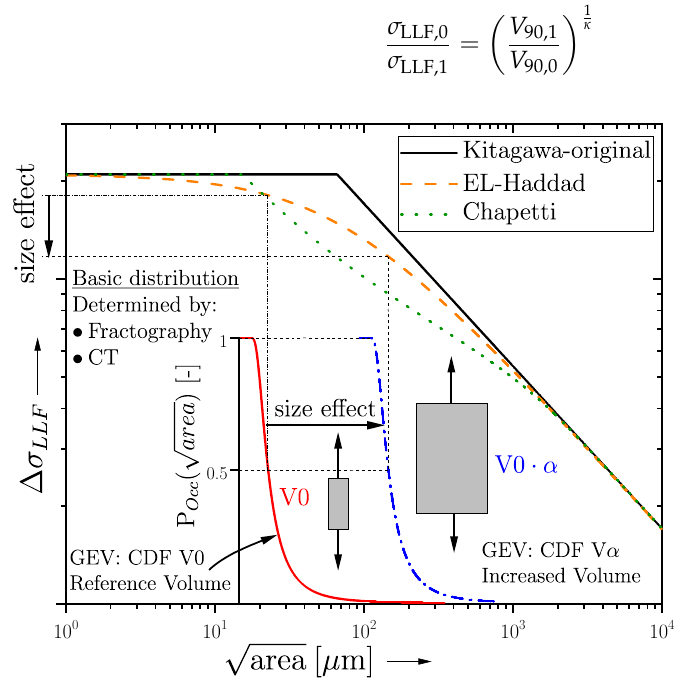
Figure 1. Setup of the Kitagawa diagram incorporating size effect (applying modification of